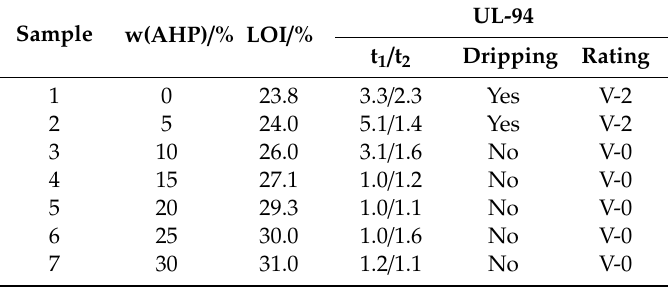
Table 4. E ff ect of AHP on the flame retardancy for BC / PLA / AHP composites.